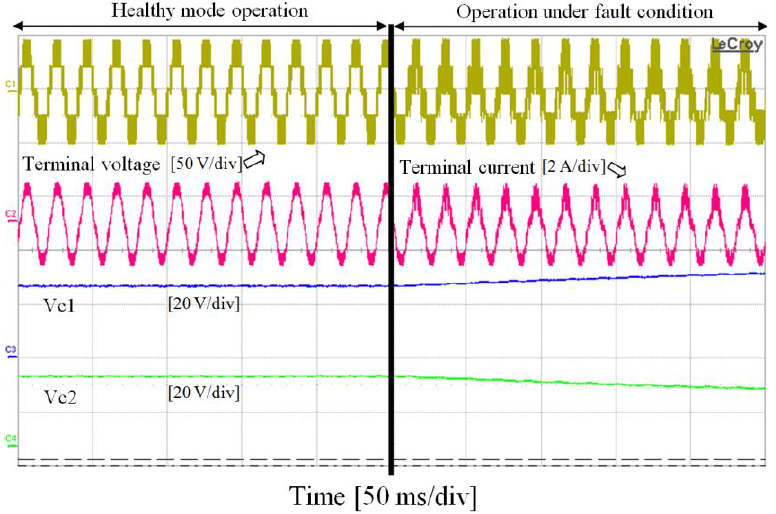
Figure 13. Experimental results of the inverter operation after blowing fuse F4 without applying fault diagnosis and fault-tolerant control.